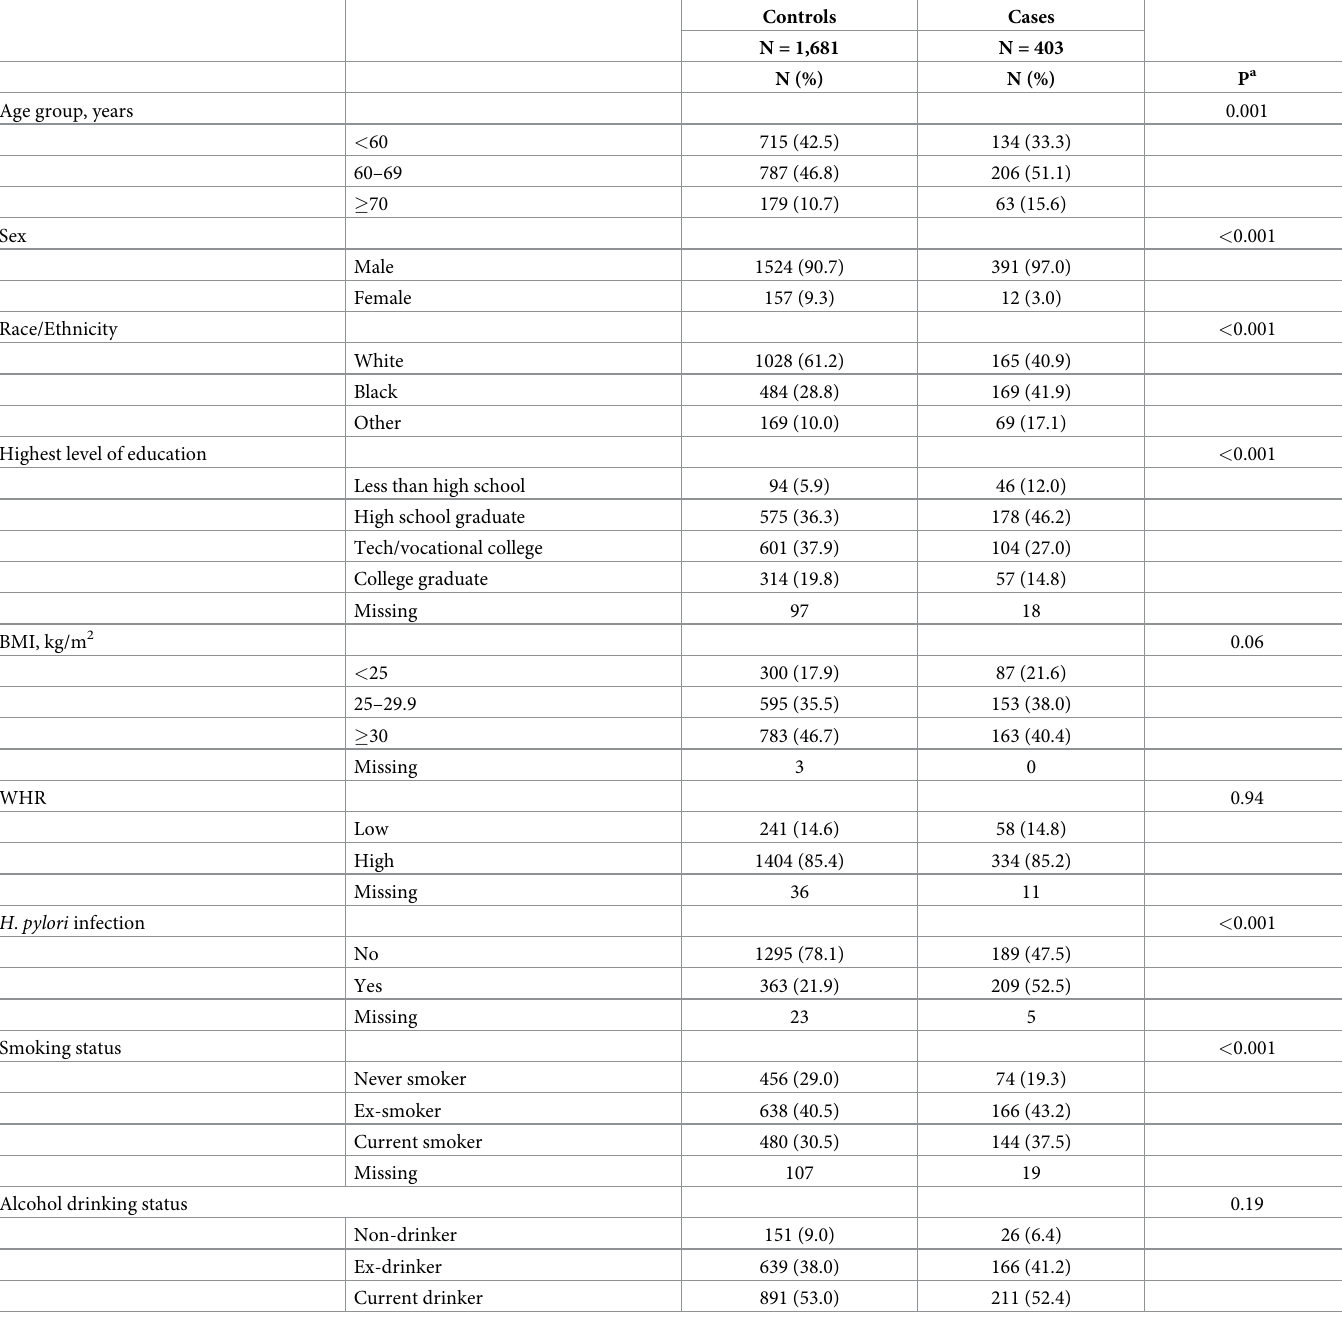
Table 1. Characteristics of cases and